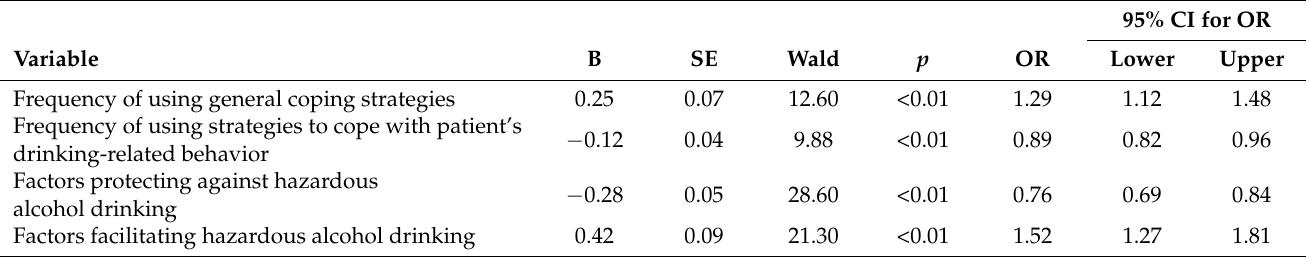
Table 3. Predictors of hazardous alcohol drinking behaviors among family members (N =